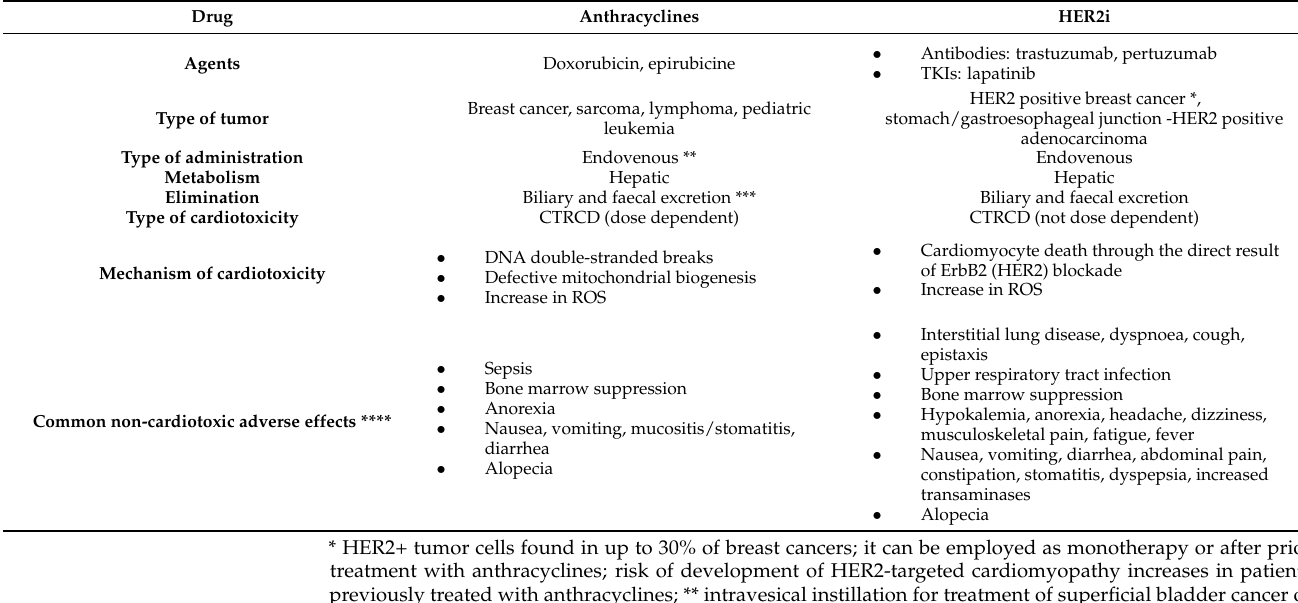
Table 1. Comparison of the main characteristics of anthracyclines and